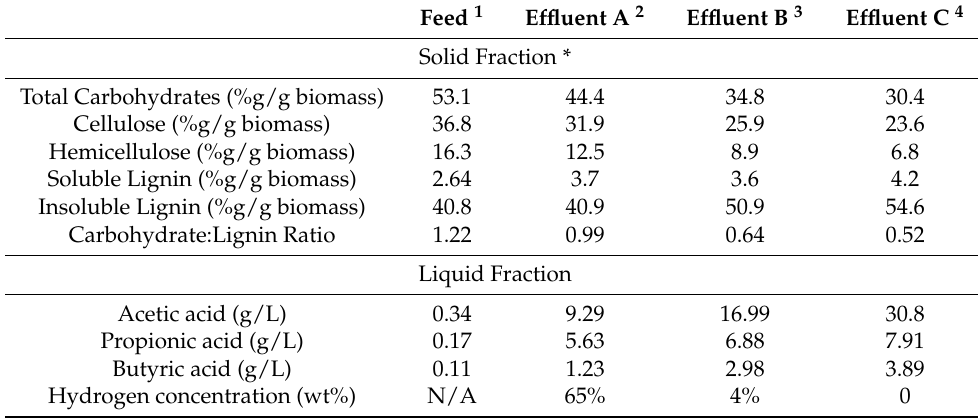
Table 3. Compositional analysis of wet exploded corn stover feed and effluent before and after bioaugmentation on day 30 of